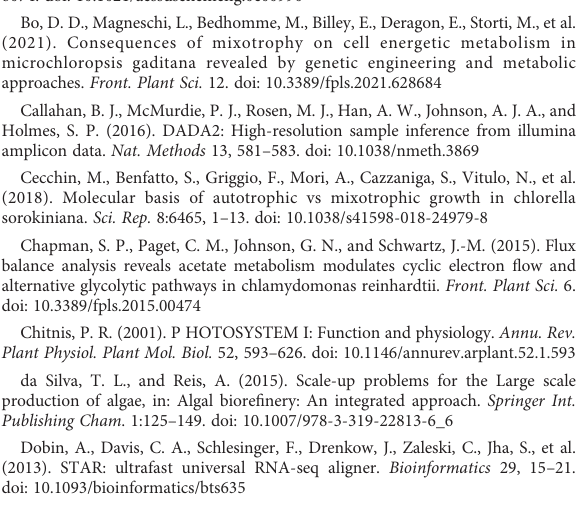
SUPPLEMENTARY FIGURE 1 Growth of S. obliquus with three different concentrations of switchgrass (SG): 0.20%, 0.30%, 0.40% w/v . Points and error bars indicate mean and standard deviation of three biological replicates. SUPPLEMENTARY FIGURE 2 Growth of S. obliquus with and without corn stem cross sections. Corn stem was harvested at day 14 for confocal microscopy and SEM analysis. Points and error bars indicate mean and standard deviation of three biological replicates. SUPPLEMENTARY FIGURE 3 Magni fi ed views of vascular bundles by scanning electron microscopy (SEM) of corn stem cross sections after being in culture with S. obliquus (A – C) or incubated with just BG-11 media (D) . Arrows point to phloem cells. SUPPLEMENTARY FIGURE 4 Magni fi ed views of phloem in vascular bundles by scanning electron microscopy (SEM) of corn stem cross sections after being in culture with S. obliquus (A – C) or incubated with just BG-11 media (D) . Long arrows points to a sieve element; small arrow points to a companion